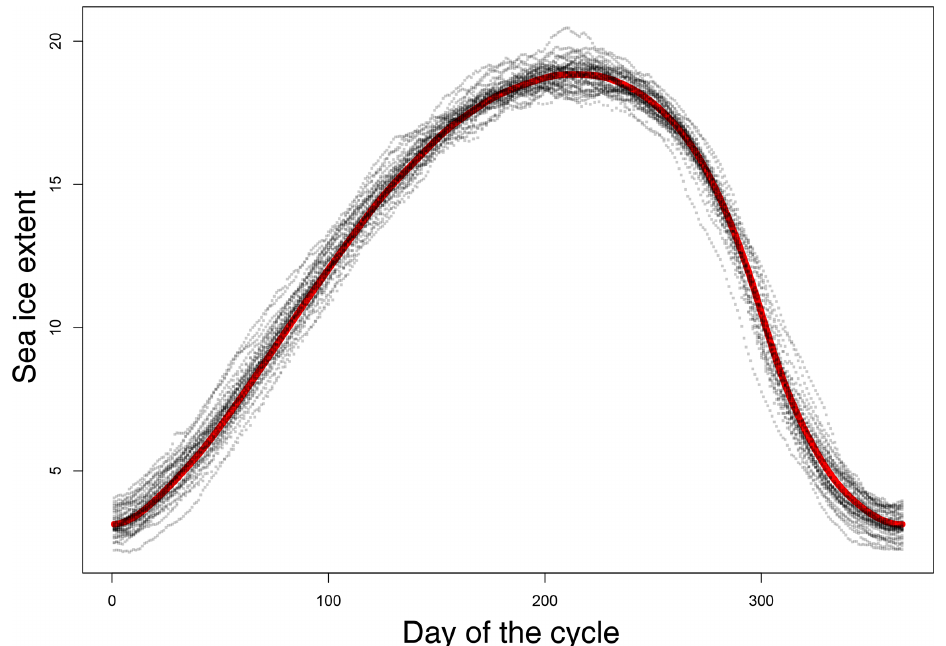
Figure 1. Recorded sea ice extent (SIE) (grey) for each year compared to a smooth annual cycle (red) over a 365d period. The horizontal axis is the day of the cycle and the vertical axis is sea ice extent in millions of square